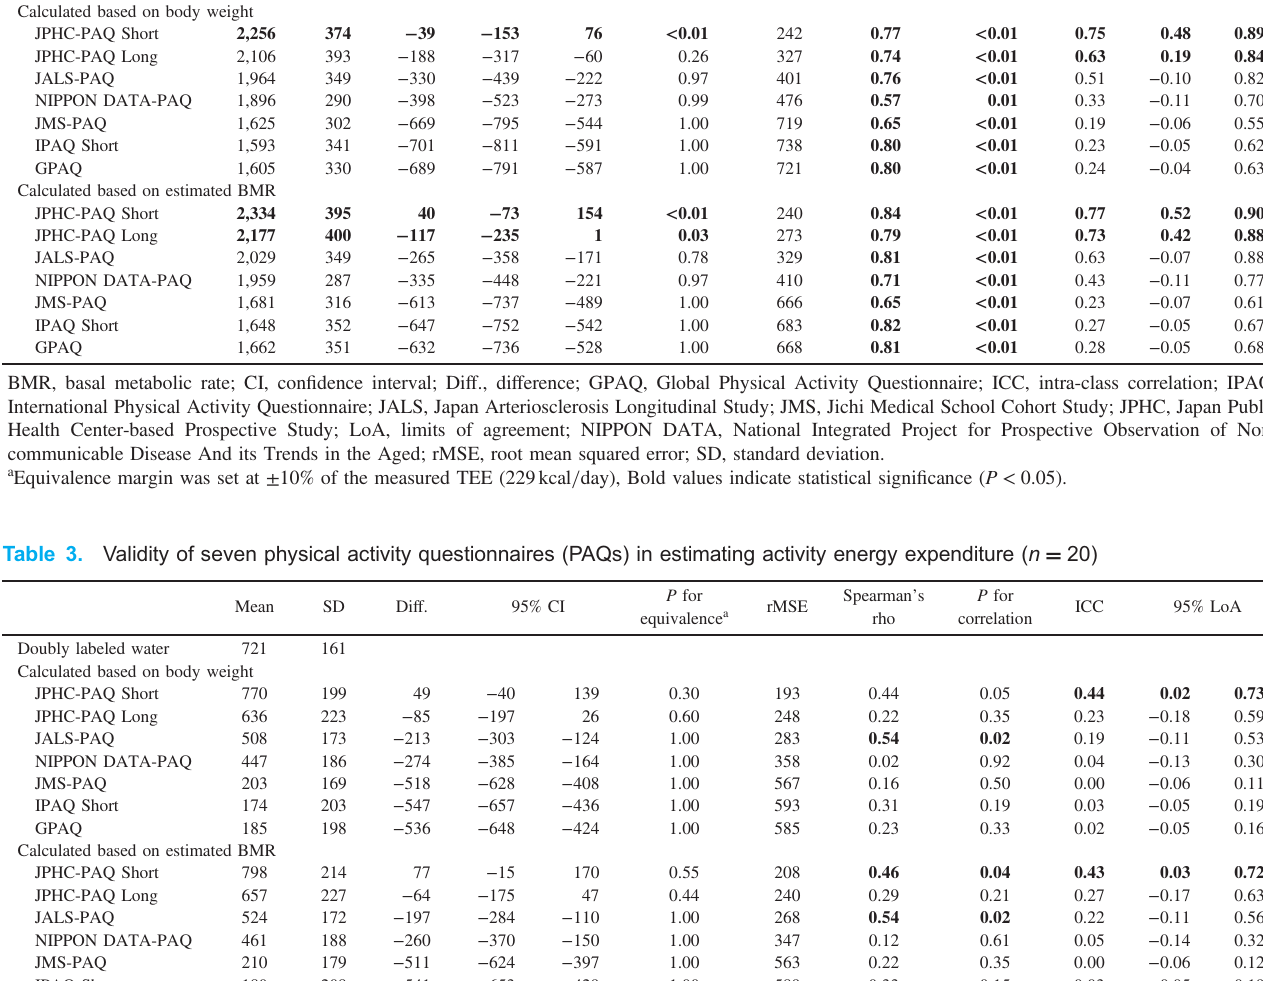
Table 2. Validity of seven physical activity questionnaires (PAQs) in estimating total energy expenditure ( n = 20) Mean SD Di ff . 95% CI Doubly labeled water 2,294 318 Calculated based on body weight